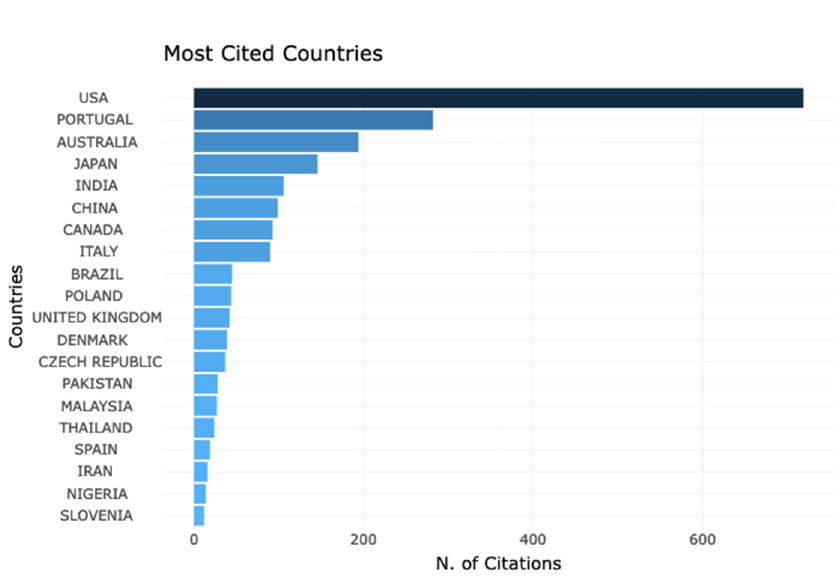
Figure 3. Citations of countries’ scientific production on geosyinthetics research entrenched with managerial implications, as considered in this study.